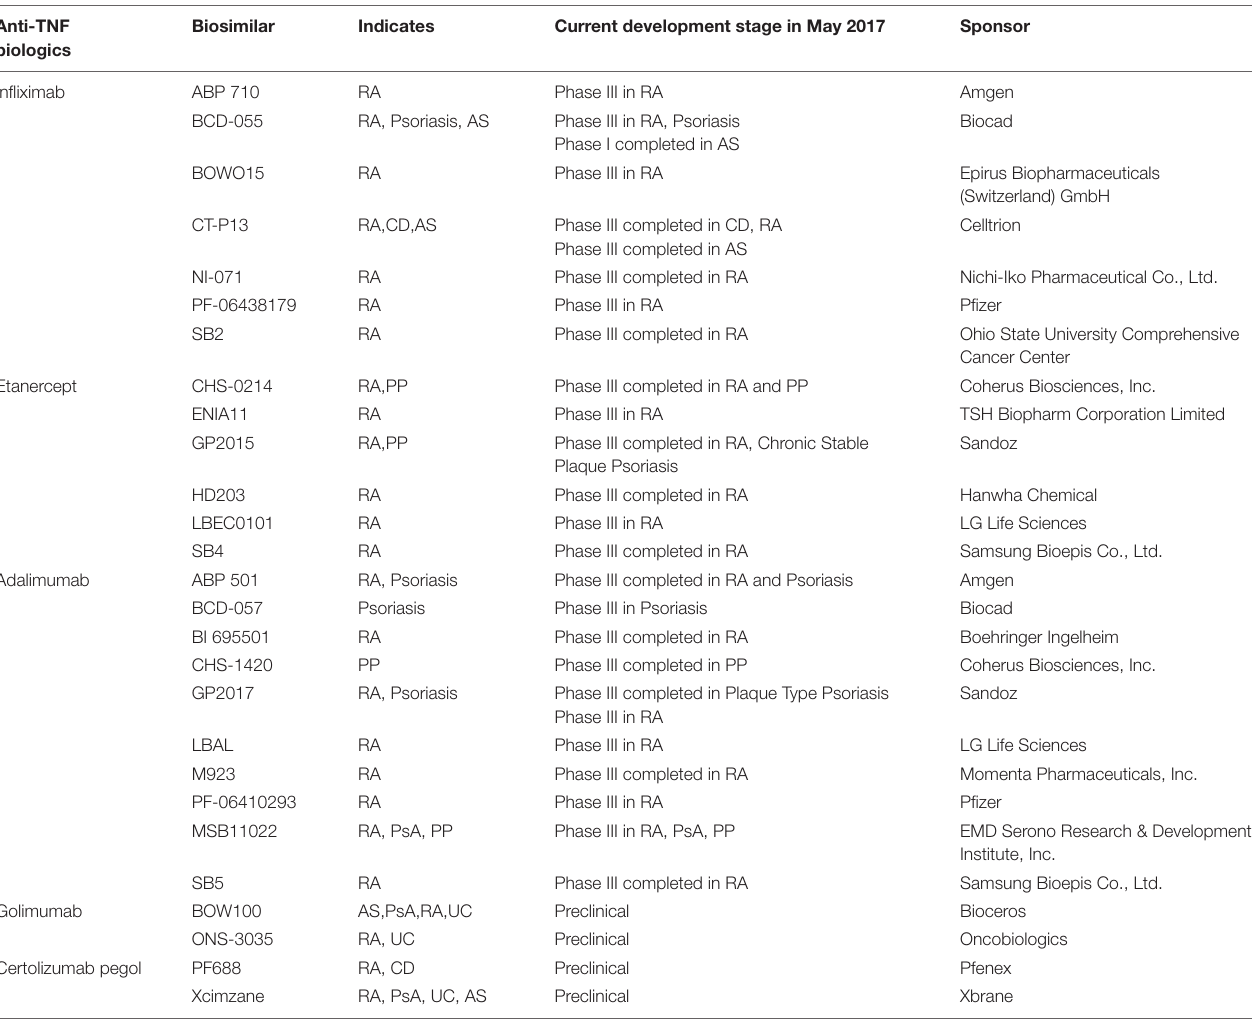
TABLE 1 | Anti-TNF biosimilars in the development for the treatment of autoimmune inflammatory diseases. Anti-TNF biologics